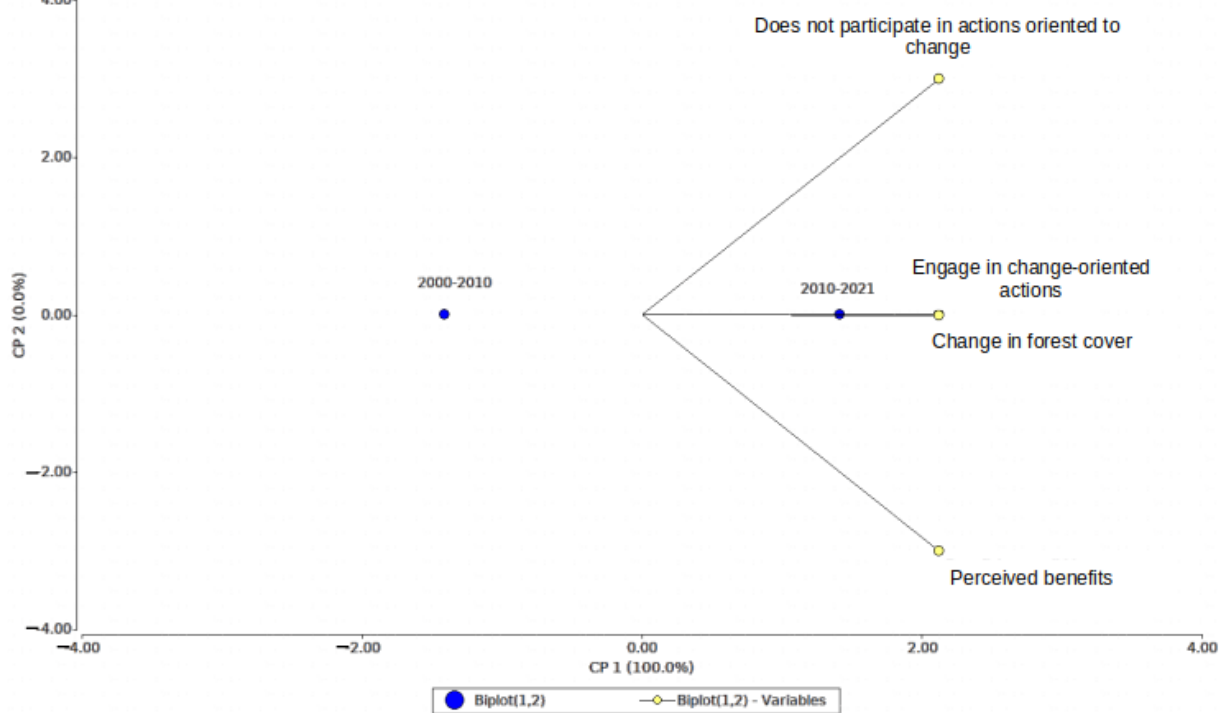
Figure 2. Principal Component Analysis between variables related to the change in forest cover in Mirador Sur Park according to the visitation period (Appendix C).